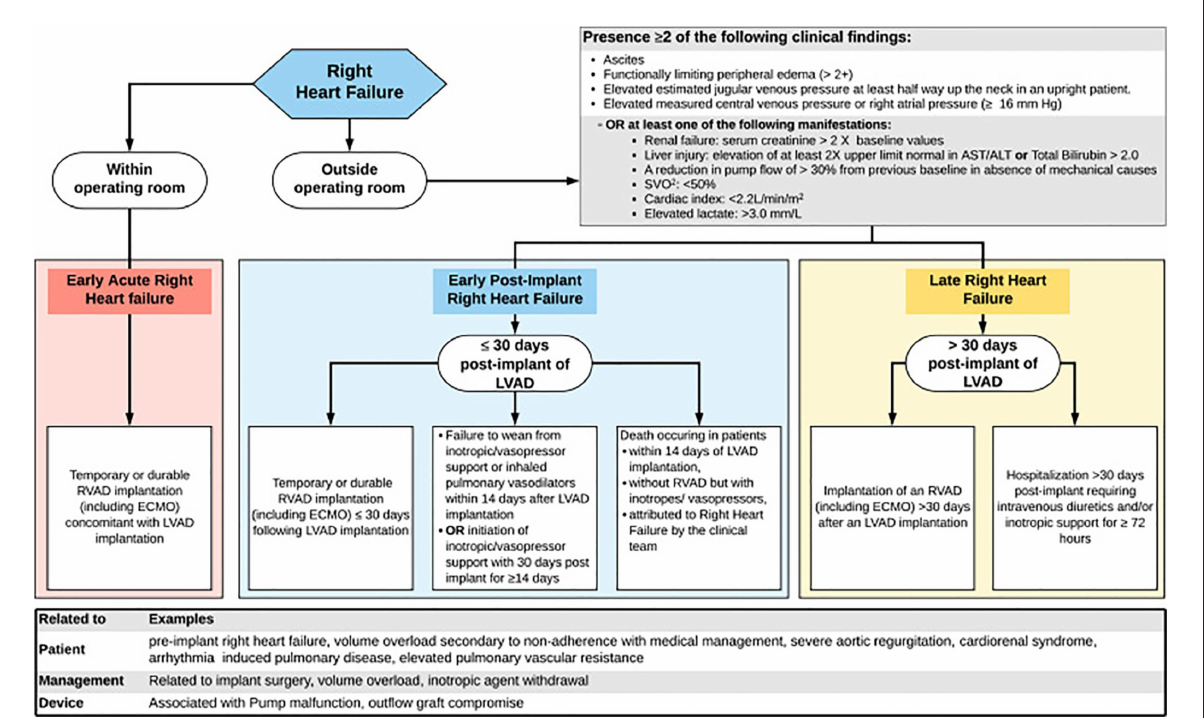
FIGURE4 Algorithm illustrating the MCS-ARC diagnostic criteria for RHF (58). The RHF events are classified as early acute if it occurs immediately after LVAD implantation, early if it is within the first 30 days post-surgery, and late if it happened > 30 days post-surgery. Additionally, for early and late RHF, the new criteria require the presence of clinical findings or manifestations suggestive of RHF, in addition to an intervention to treat this complication. Reproduced from Kormos